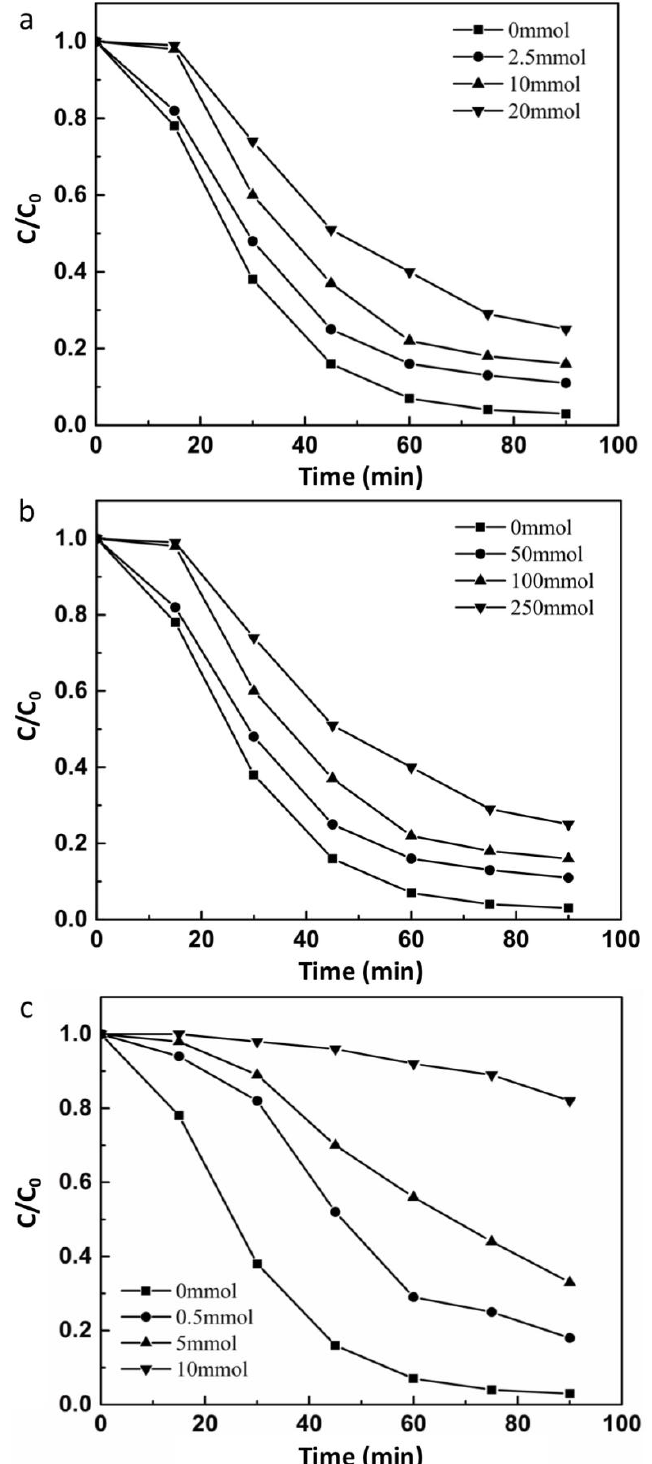
ff ect of AA ( a ), TBA ( b ) and His ( c ) on the phenol removal by Fe-Ni / Figure 7. Effect of AA ( a ), TBA ( b ) and His ( c ) on the phenol removal by Fe-Ni/MAC. Figure 7. E